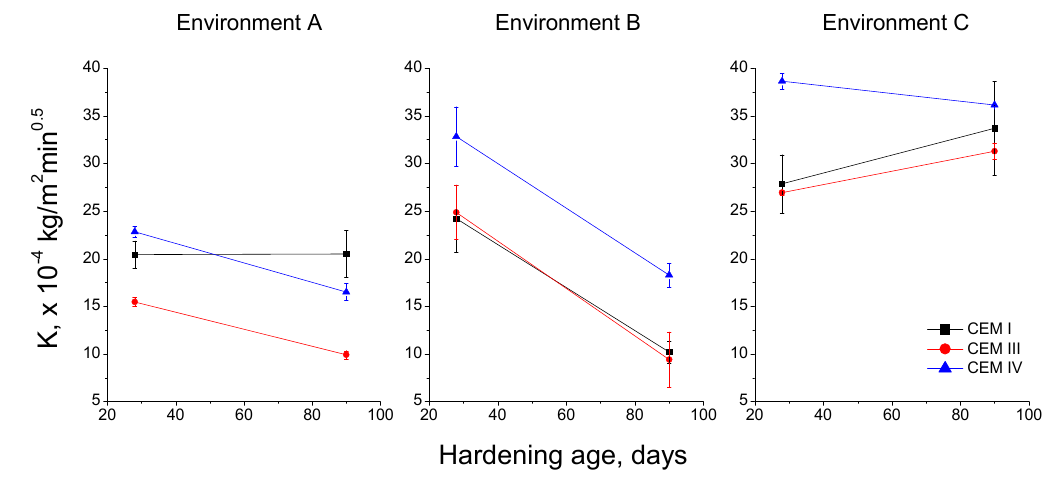
Figure 12. Capillary suction coefficient (K) results for each environment.